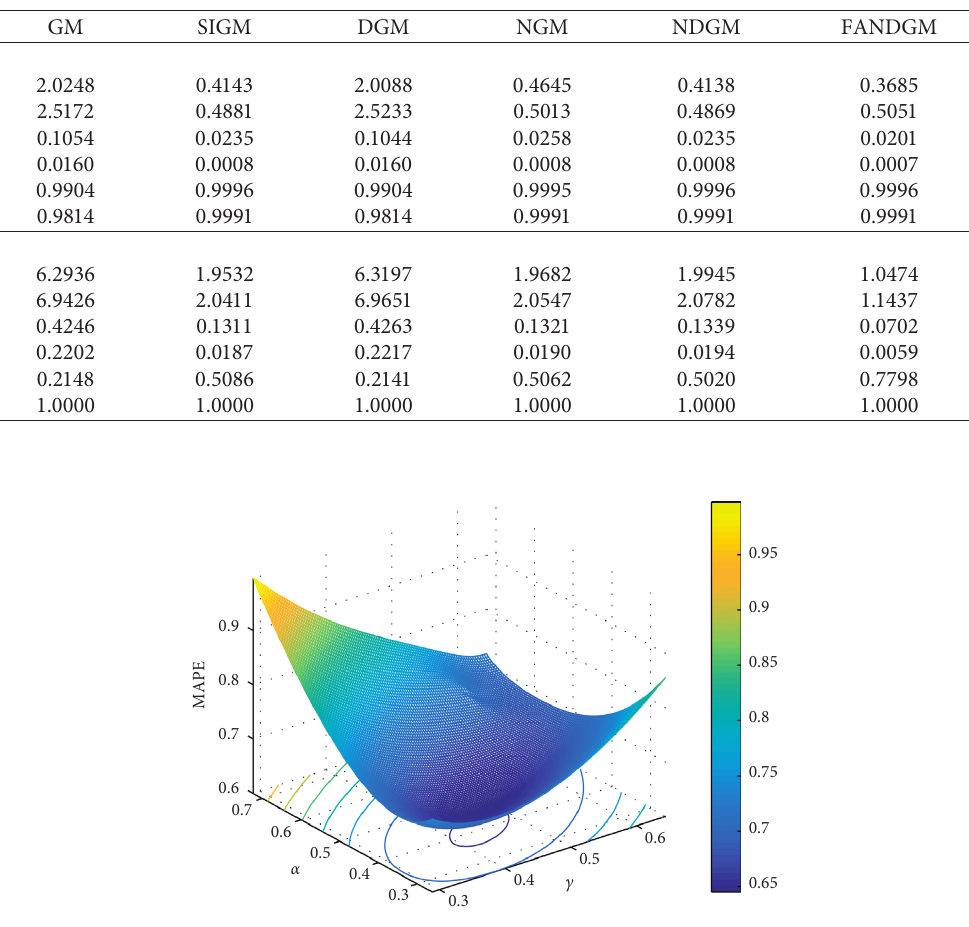
Figure 10: The relationship between MAPE and parameters.